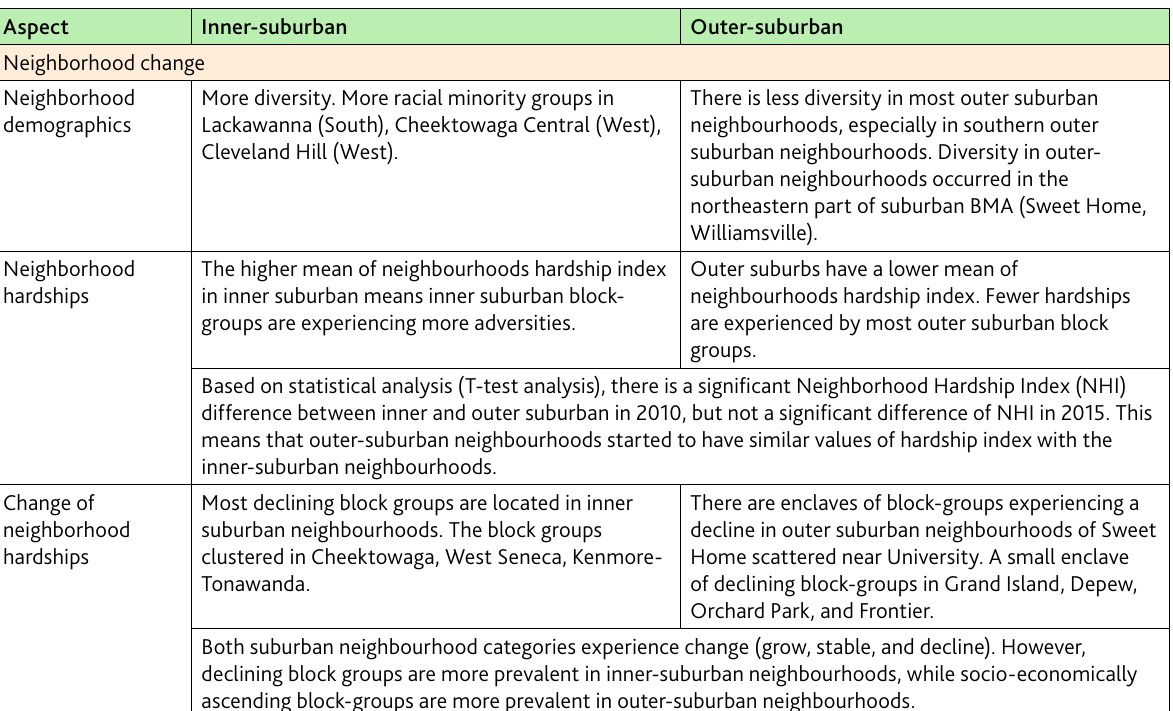
Table 2. The highlight of the difference between inner and outer suburban neighborhoods Aspect Inner-suburban